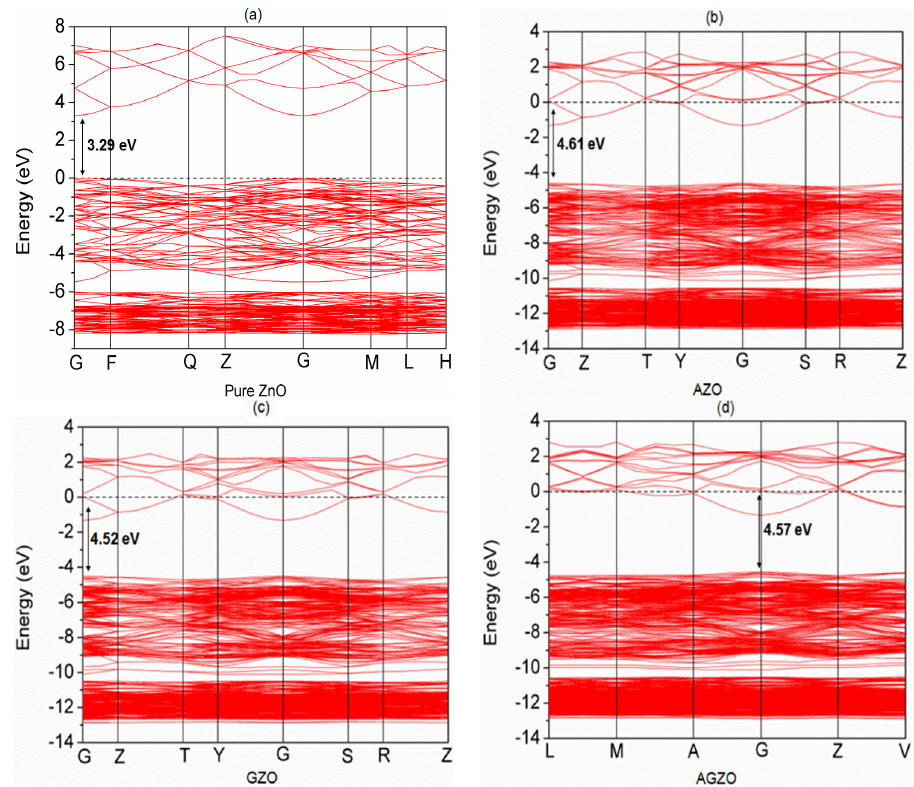
Figure 3. Band structures of ( a ) pure ZnO; ( b ) AZO; ( c ) GZO; and ( d ) AGZO.